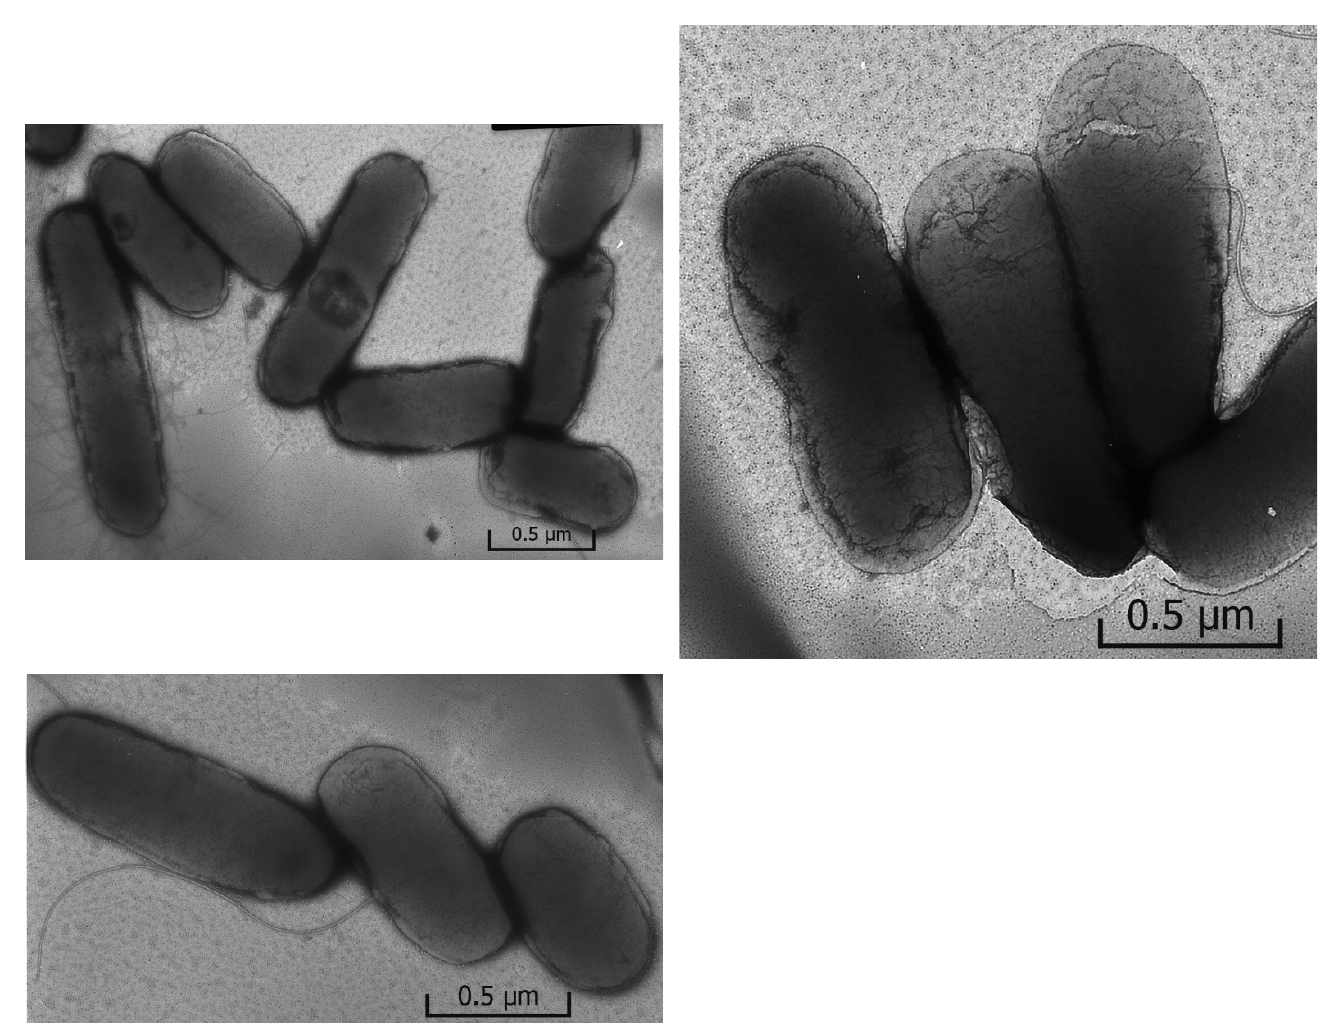
Figure 8. Photomicrographs of Escherichia coli grown in the presence of silver ions (1 × 10 − 5 mol L − 1